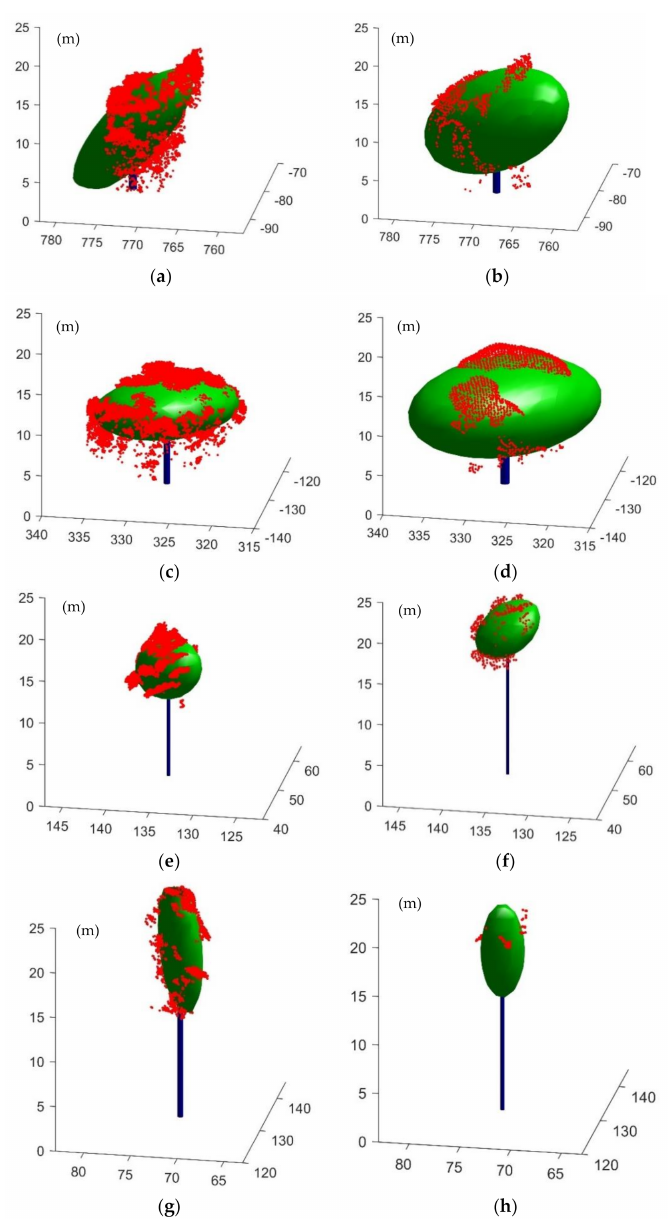
Figure 10. 3D model by ellipsoid fitting method of ( a ) the first tree sample using the LiDAR method, ( b ) the first tree sample using the photogrammetric method, ( c ) the second tree sample using the LiDAR method, ( d ) the second tree sample using the photogrammetric method, ( e ) the third tree sample using the LiDAR method, ( f ) the third tree sample using the photogrammetric method, ( g ) the fourth tree sample using the LiDAR method, and ( h ) the fourth tree sample using the photogrammetric